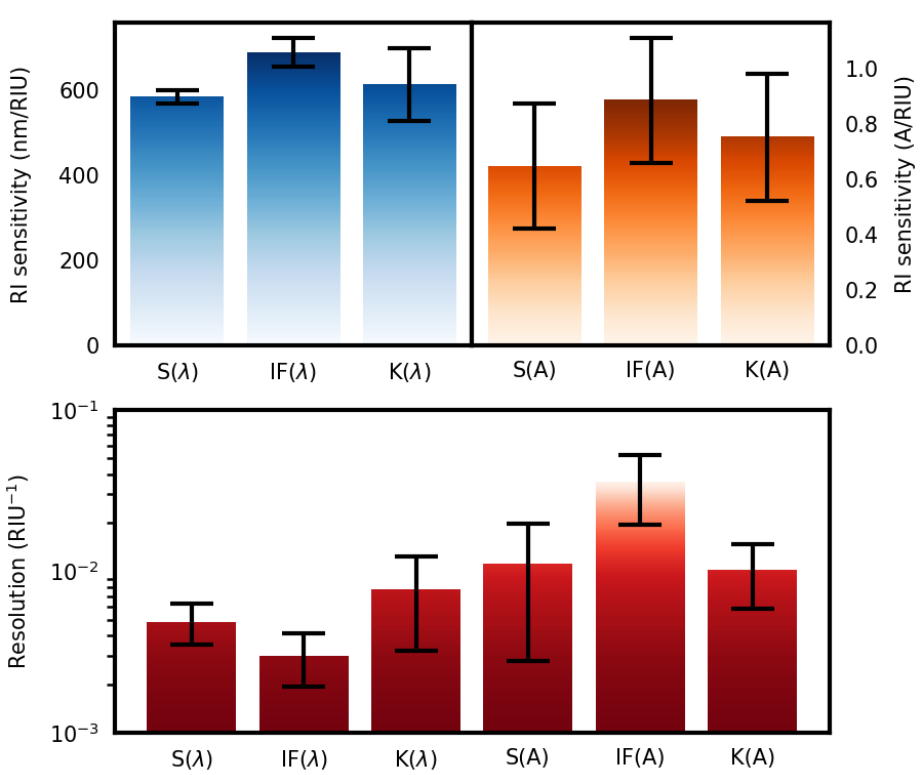
Figure 5. Top panel: Box plots of the RI sensitivity for the six analysis methods studied. Bottom panel: RI resolution comparison for the studied analysis